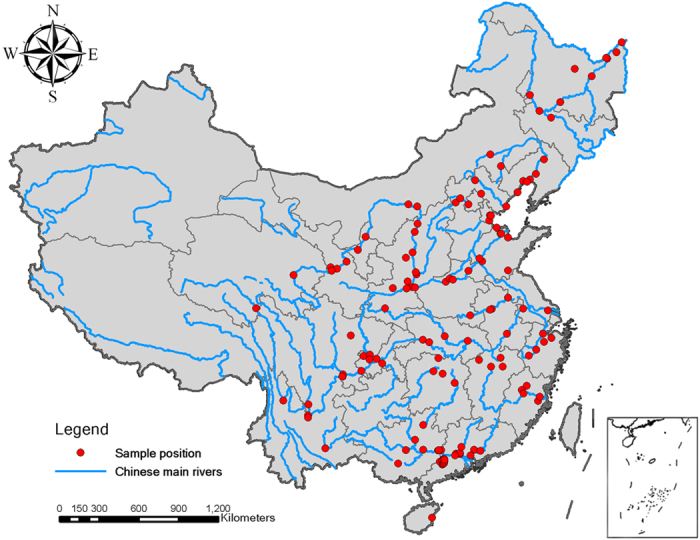
Distribution of the survey position of the basin outlet in this synthesis.The map was generated using ArcGIS for Desktop 10.0 (http://www.esri.com/software/arcgis).